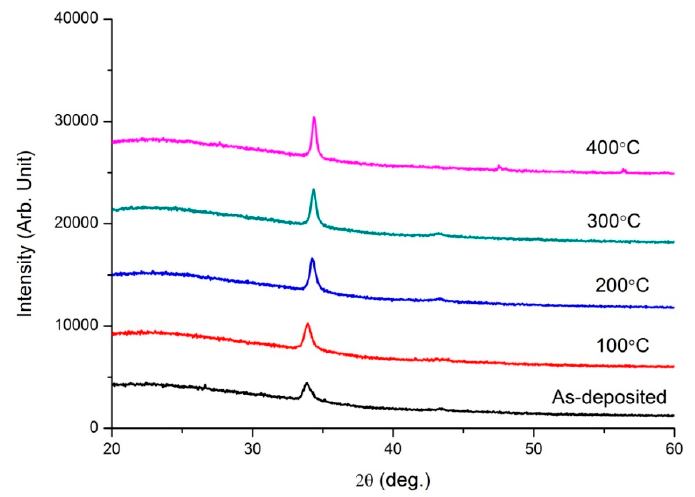
Figure 3. XRD spectra of ZnO(Ti/Cu) film system with varying annealing temperature.